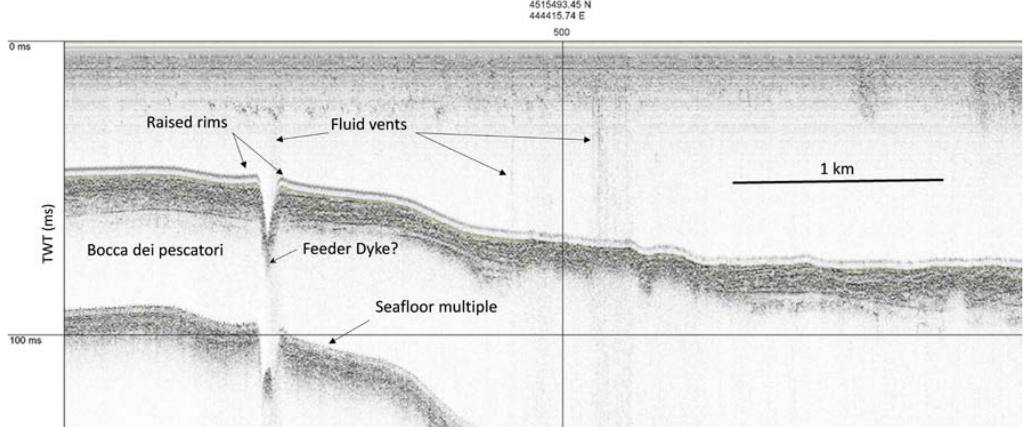
Figure 4. S1 Chirp mono-channel seismic profile acquired on Bocca dei Pescatori. The navigation line is in Figure 1.